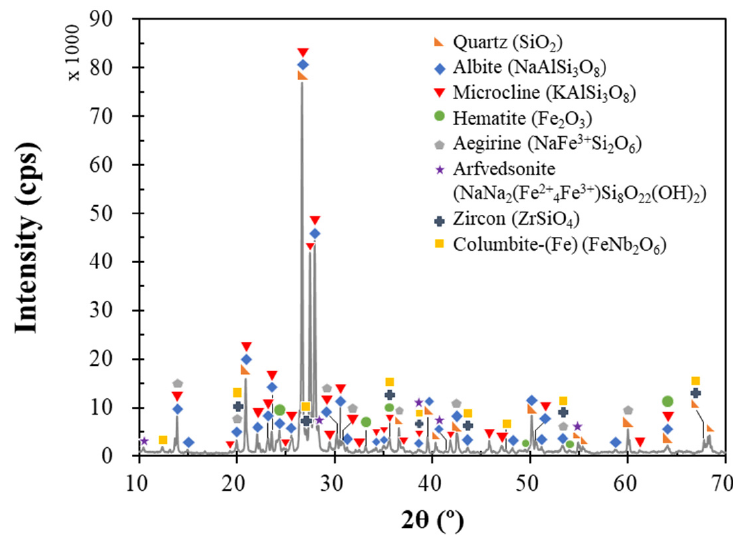
560 ± 33 * Abbreviation: n.d., not detected. The mineralogical composition of the sample was determined by XRD (Figure 4). As shown in the XRD pattern, quartz and aluminosilicates (e.g., albite (NaAlSi 3 O 8 ) and mi- crocline (KAlSi 3 O 8 )) were identified as the main gangue minerals in the sample, which is consistent with the XRF result (Table 1). Meanwhile, hematite (Fe 2 O 3 ), aegirine